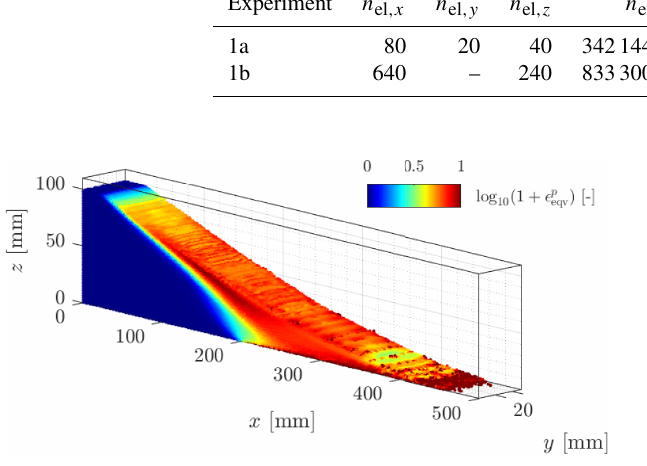
Figure 7. Equivalent plastic strain (cid:15) p eqv for the final configuration of the granular collapse. The principal feature of a granular collapse can be observed, i.e. a backward propagation of plastic deformation along a principal failure surface.